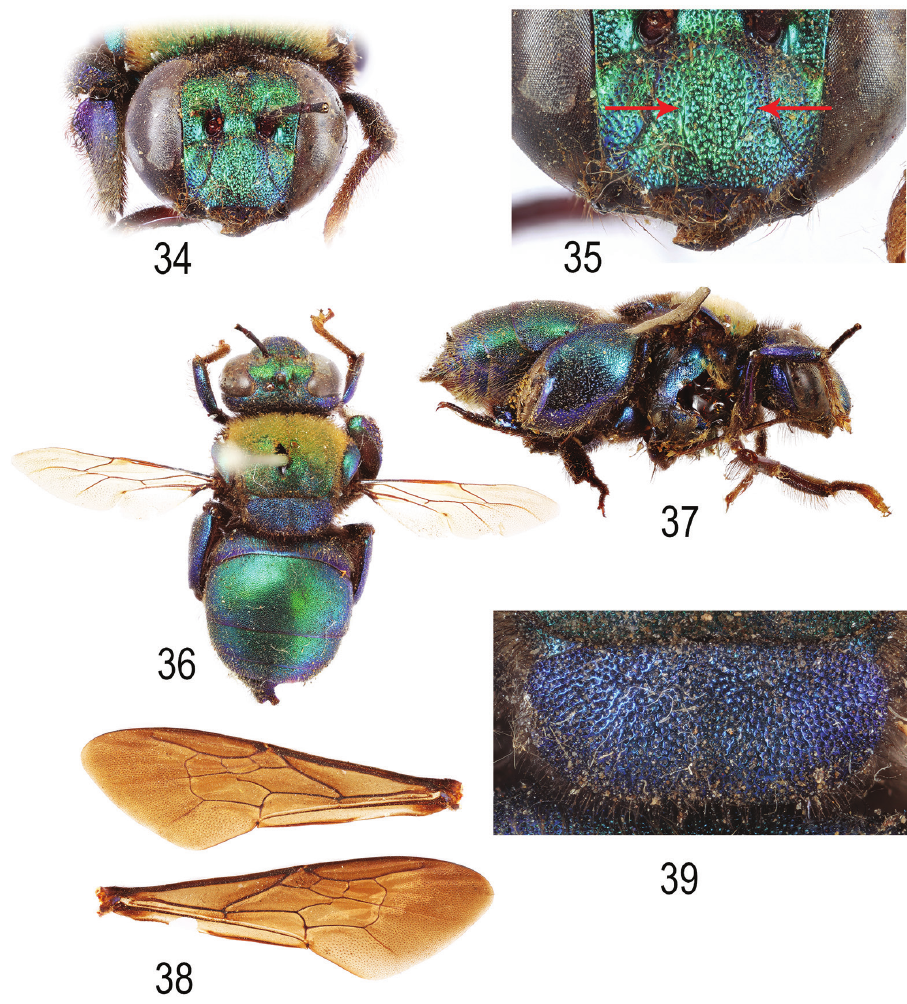
Figures 34–39. Male lectotype of E. coerulescens . 34 Facial view 35 Detail of clypeus with arrows in- dicating weak sublateral ridges that form a median longitudinal depression 36 Dorsal habitus 37 Lateral habitus 38 right and left forewings 39 Dorsal view of